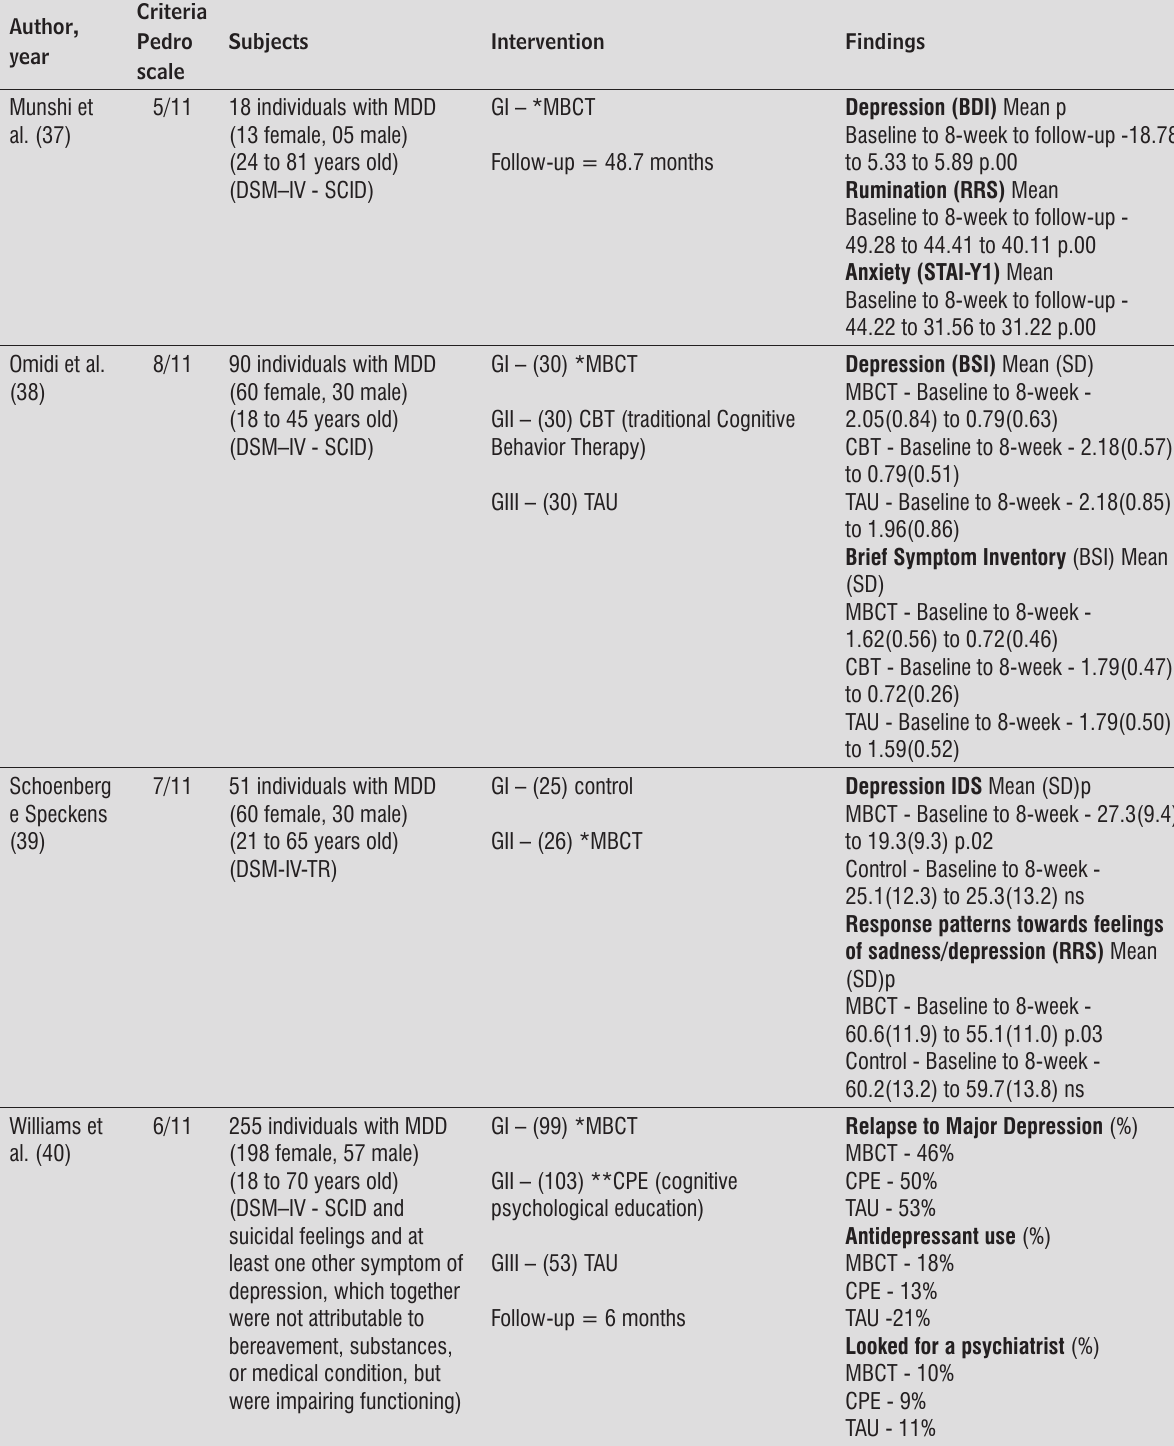
Table 2 - Characteristics of the studies Interventions